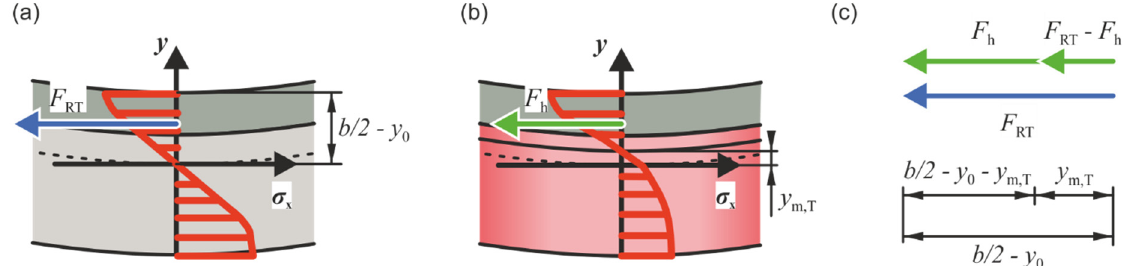
Figure 8. Relation between cross-sectional forces and stress-free fiber. ( a ) Room-temperature case, ( b ) partially heated case, ( c ) Relation between force and stress-free fiber.